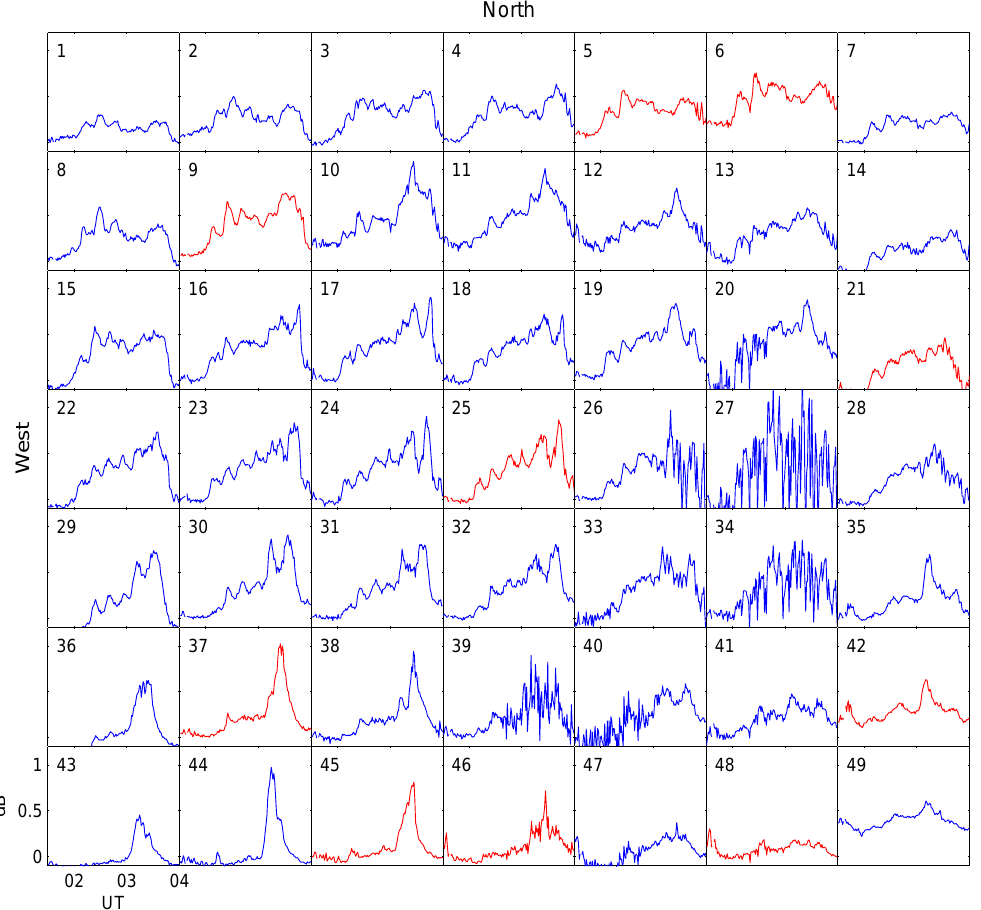
Fig. 3. Data from all 49 beams of IRIS for the duration of the pulsation. Note that the data in the four corner beams (1, 7, 43, 49) should be ignored due to the small elevation angles and large side-lobes. Scintillation is clear in beams 20, 26, 27, 33, 34, 39 and 40, caused by the passage of a radio star through the beam. Red lines indicate those beams closest to the magnetometer